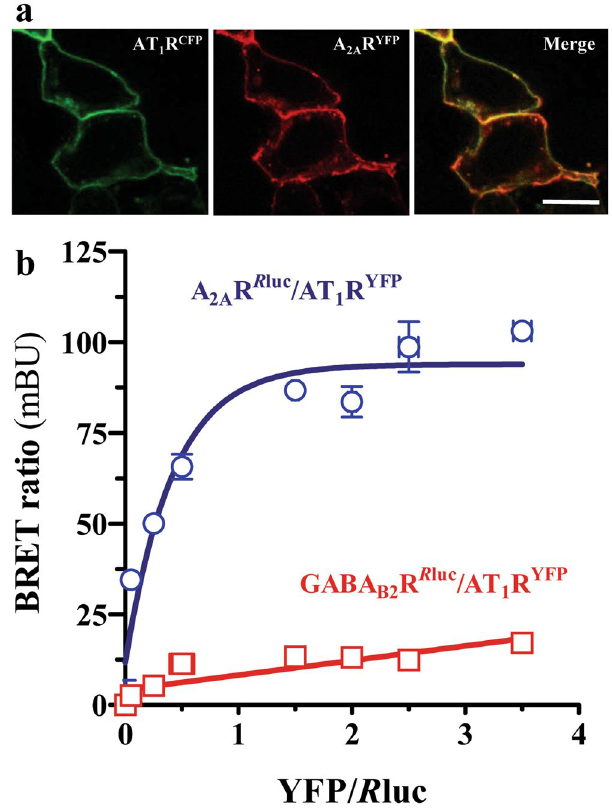
Figure 1. AT 1 R and A 2A R physically interact in HEK-293T cells. ( a ) Co-distribution of AT 1 R and A 2A R in HEK-293T cells. Transiently transfected HEK-293T cells with AT 1 R YFP (red) and A 2A R CFP (green) were fixed and observed by confocal microscopy. Co-distribution (yellow) is shown in the merge image. Scale bar : 10 µ m. ( b ). Direct interaction between AT 1 and A 2A receptors. BRET saturation curves in HEK-293T cells expressing A 2A R R luc and AT 1 R YFP (blue) or GABA B2 R R luc and AT 1 R YFP (red). Plotted on the x-axis is the fluorescence value obtained from the YFP, normalized with the luminescence value of R luc-tagged vectors 10 min after benzyl- coelenterazine incubation. Results are expressed as mean ± SEM (n = 3, in